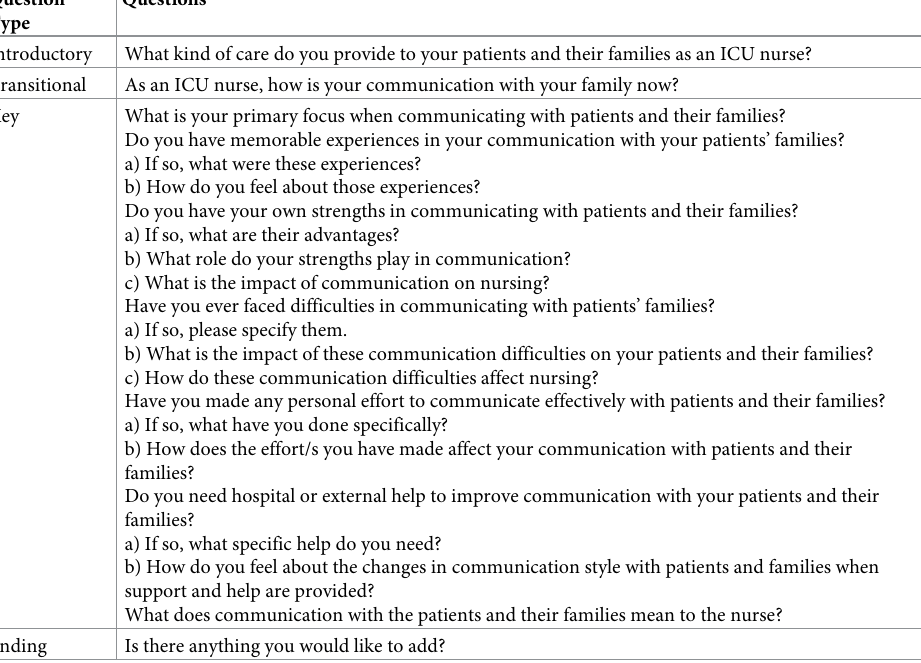
Table 2. List of interview